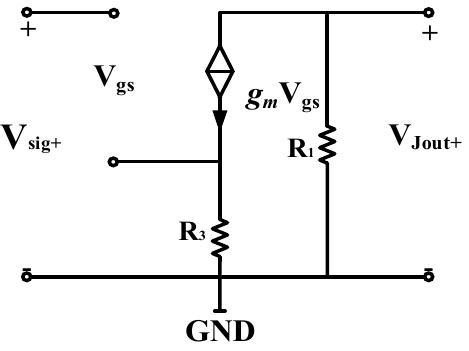
Figure 8. Analysis of AC small signal model of JFET differential circuit.